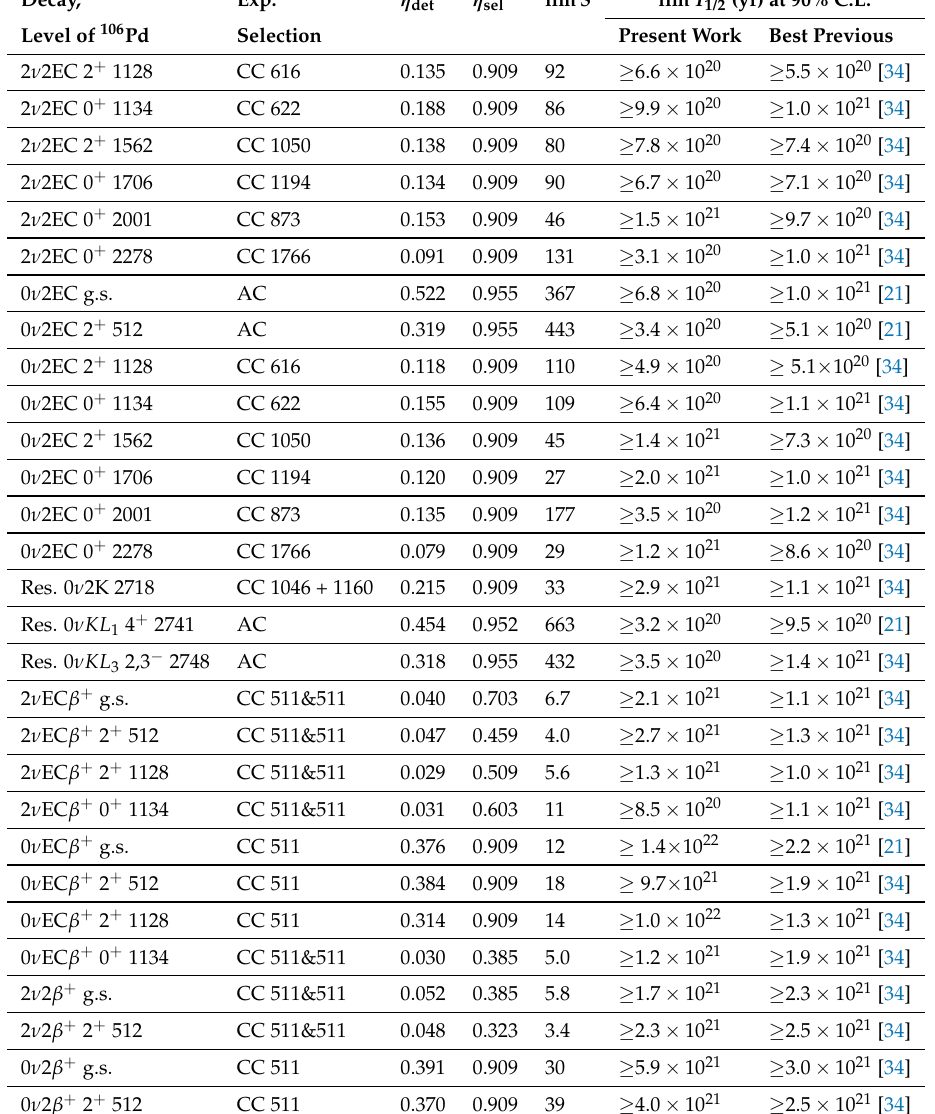
Table 2. Half-life limits on 2 β processes in 106 Cd. The experimental selection is also reported (AC, anti-coincidence; CC, in coincidence, at the given energy (energies) with CdWO 4 ; CC 511&511, in coincidence with energies 511 keV in both of the CdWO 4 counters). η det denotes the detection efficiency, η sel is the selection cuts efficiency. The results of the most sensitive previous experiments are given for